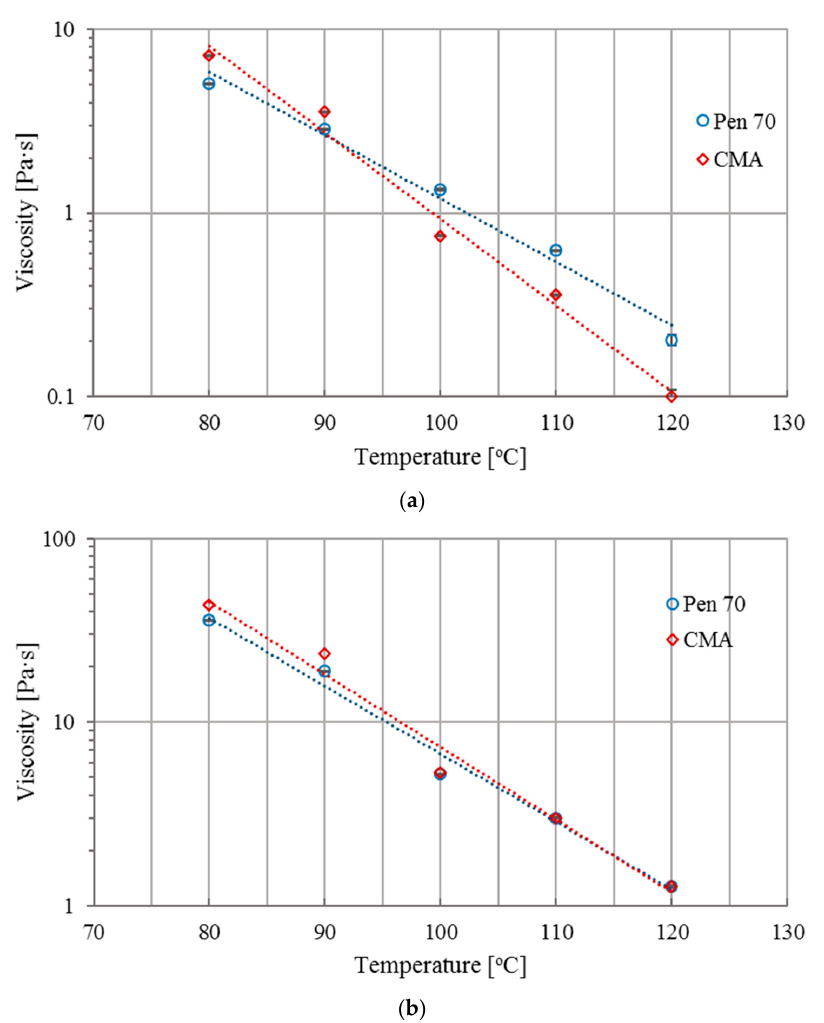
Figure 3. Viscosity of asphalt binders: ( a ) before and ( b ) after RTFO aging .